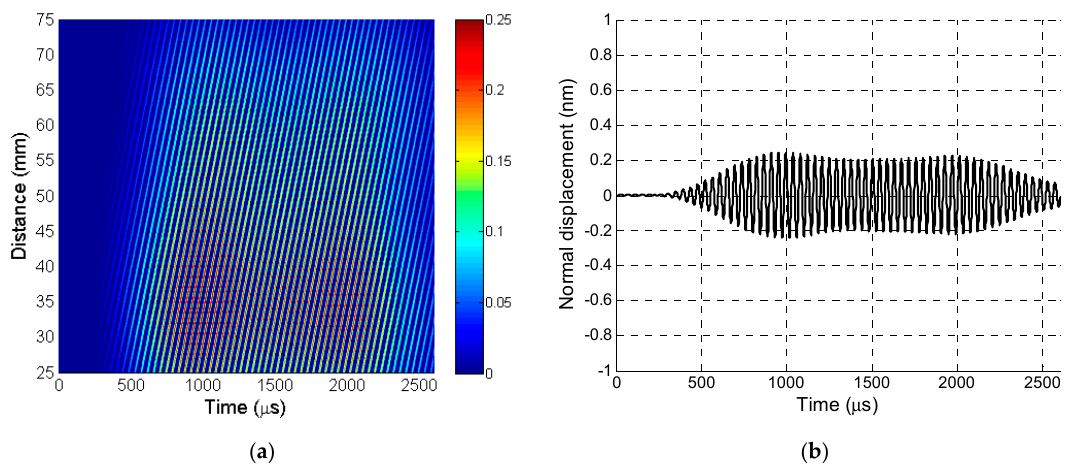
Figure 13. ( a ) B-scan recorded by laser interferometer after 2D filtering. ( b ) A-scan signal taken from B-scan after 2D filtering at a distance of 37.5 mm.